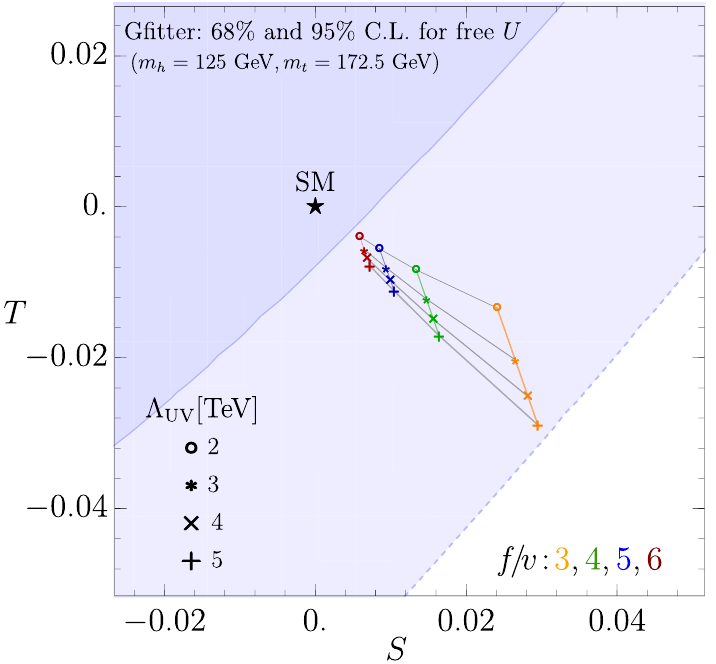
Figure 5 . The allowed region in the S T plane leaving the U parameter free [59]. The colored (cid:0) points (orange, green, blue, and red) indicate the values of S and T for f=v = 3 ; 4 ; 5 ; 6 with UV cuto(cid:11) scale 2 ; 3 ; 4 ; 5